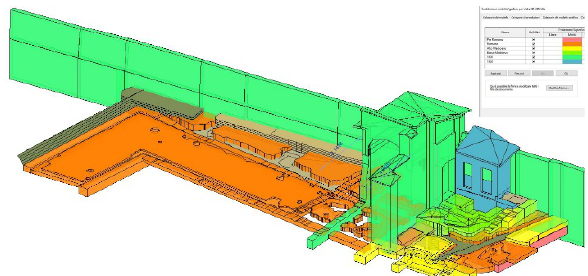
Figure 12: visualization of the archaeological area (mosaics and structures) according to the historical reconstruction made by